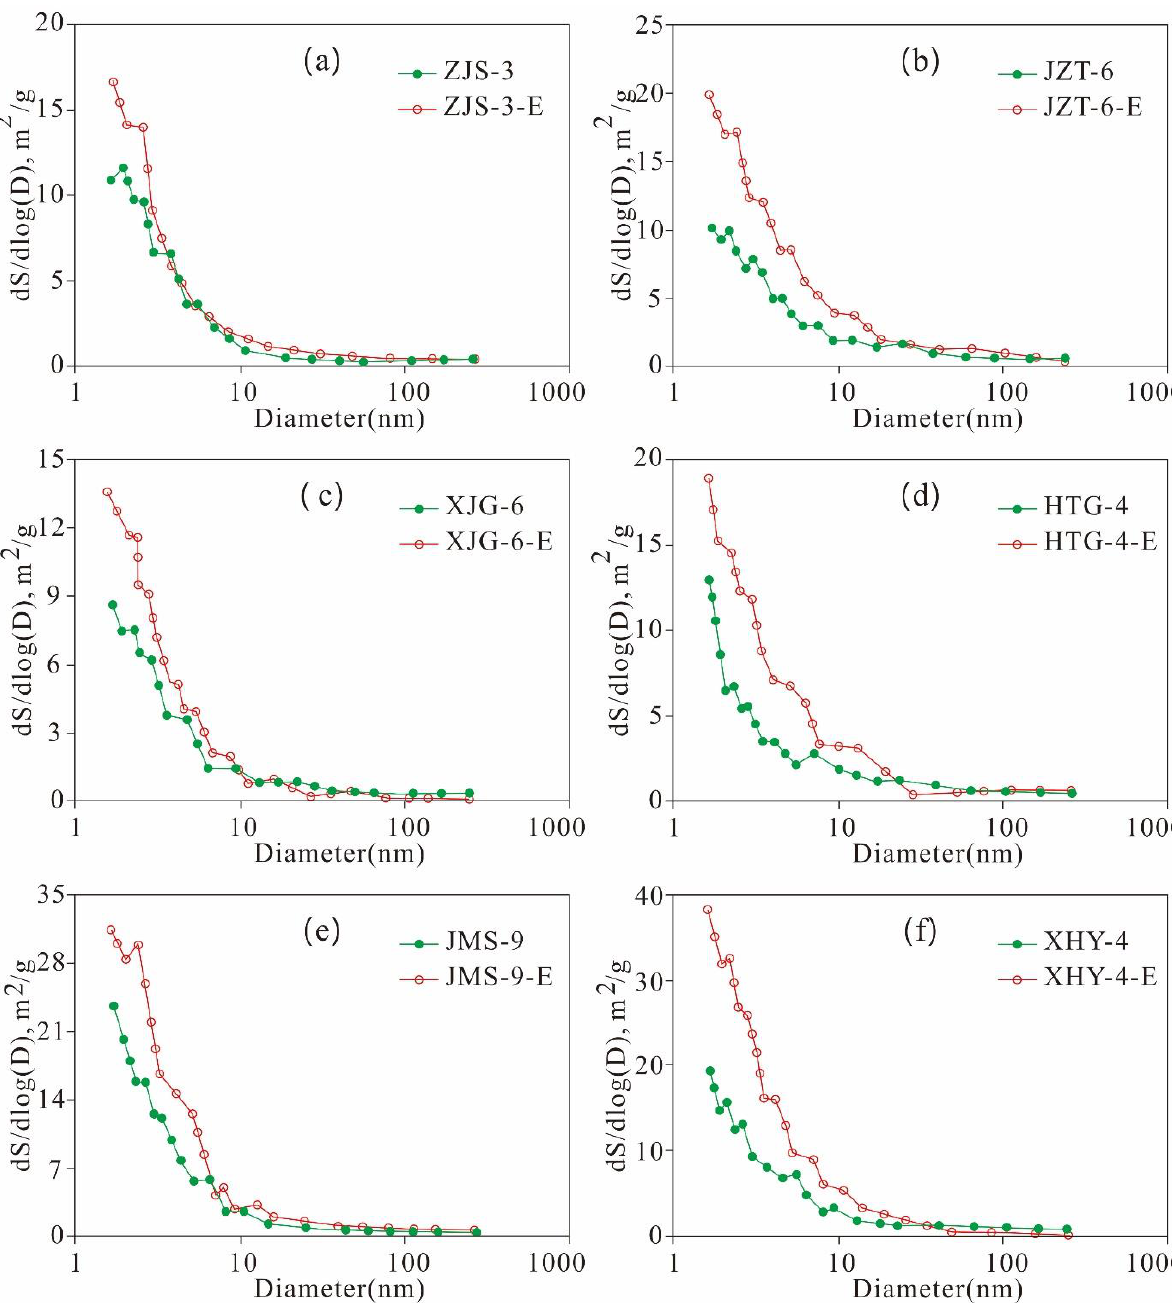
Figure 24. Mesopore and macropore SA of the original shale and its corresponding extracted sample varies with the pore size (( a ), ZJS-3; ( b ), JZT-6; ( c ), XJG-6; ( d ), HTG-4; ( e ), JMS-9; ( f ), XHY-4).